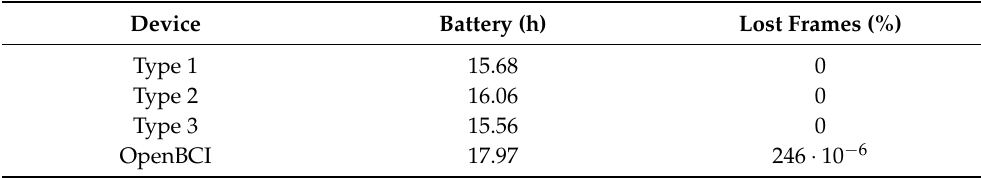
Figure 9. Battery voltage level over time. Under 3.6 V the devices turn off. Table 6. Battery lifetime and frame loss rate for the four